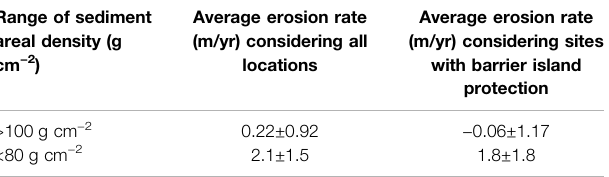
TABLE 2 | Average erosion rates (for 1980 – 2000 period) for different ranges of coarse sediment areal density. Range of sediment Average erosion rate areal density (g (m/yr) considering all cm − 2 )